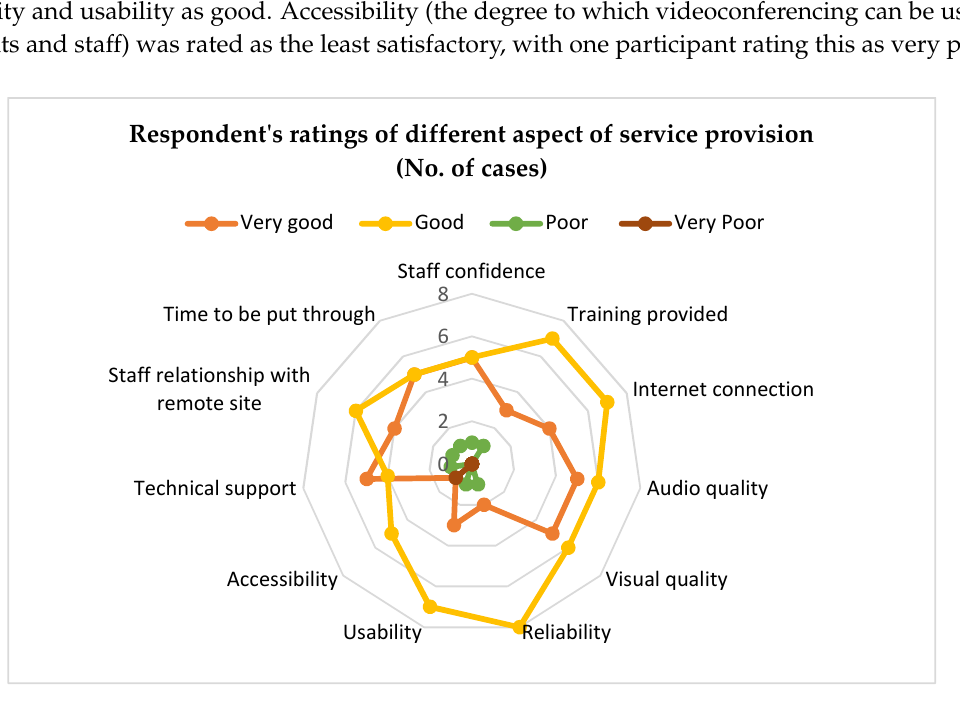
Figure 4. Breakdown of how respondents rated the effect of videoconferencing on outcomes.